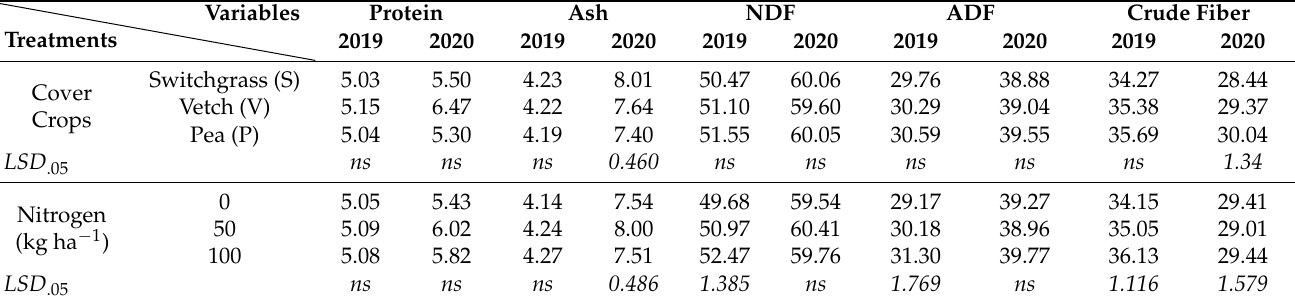
Table 4. Qualitative characteristics of the harvested biomass at the second cut (October) in switchgrass cultivation derived from a monoculture and mixed crop with vetch or pea under the regime of different (nitrogen) fertilization levels during the cultivation years 2019 and